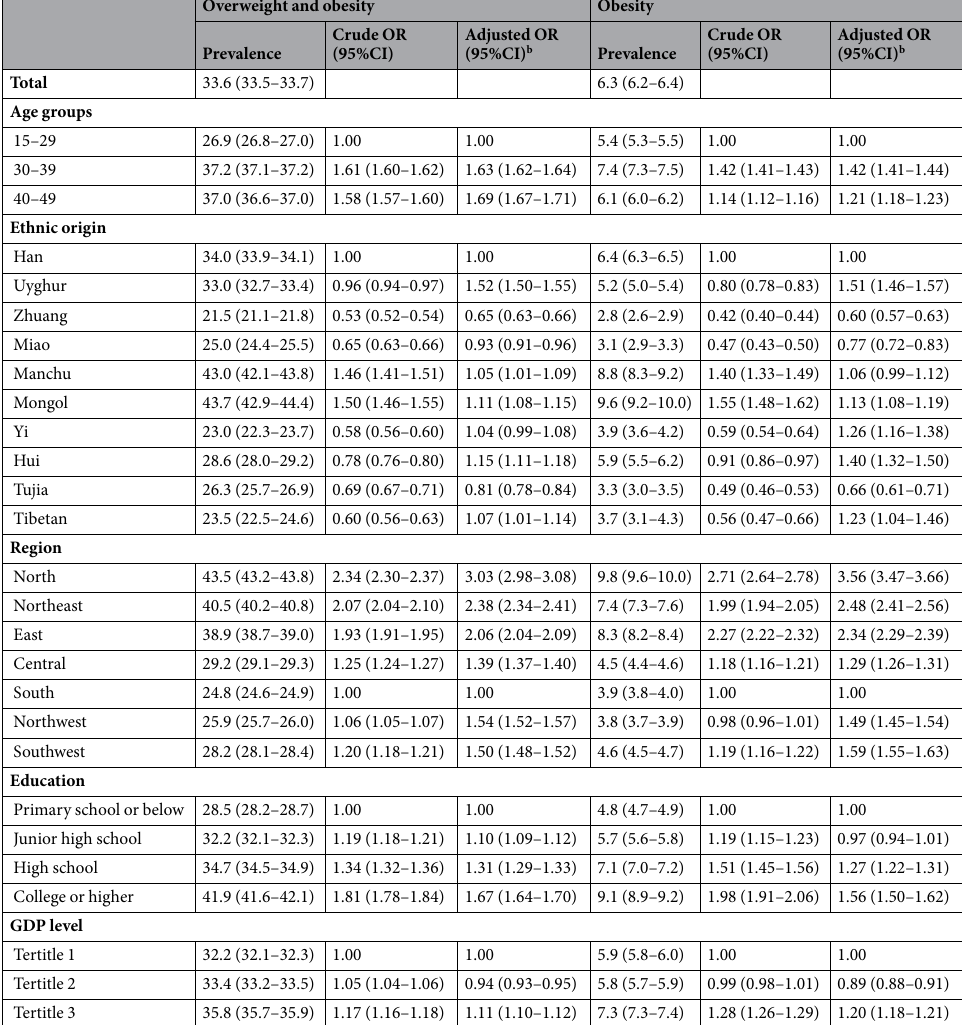
Table 2. Prevalence of overweight and obesity for reproductive-age men aged 15–49 years in rural China, 2010–2014 a . OR, odds ratio; CI, confidence interval. a Data are shown as prevalence (95% confidence interval), and all estimates were weighted using the China Population Census in 2010. Overweight and obesity were defined according to the Chinese criteria: overweight, 24.0 ≤ BMI ≤ 27.9 kg/m 2 and obesity, BMI ≥ 28.0 kg/m 2 . b Adjusted for all other factors in the